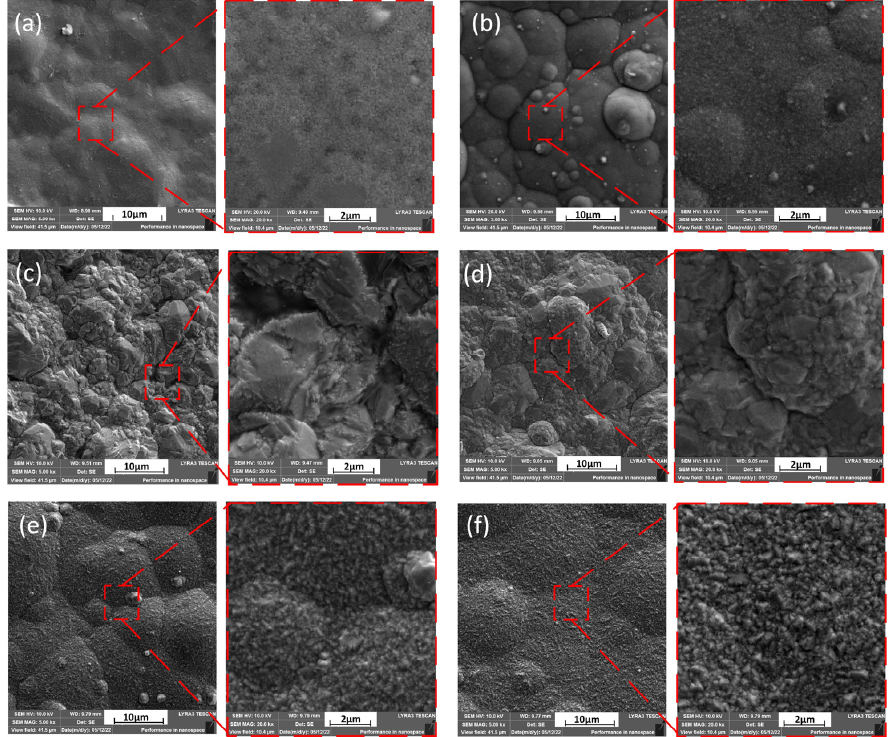
Figure 4. Microstructures of the sample surface and local enlargements of their feature areas at different low temperatures ranging from − 5 ◦ C to 5 ◦ C. ( a ) − 5 ◦ C, ( b ) − 3 ◦ C, ( c ) − 1 ◦ C, ( d ) 1 ◦ C, ( e ) 3 ◦ C, ( f ) 5 ◦ C. ( e , f ) show the electrodeposited copper sample with the smallest grain size and the most delicate structure, followed by ( a , b ). The electrodeposited copper layer in ( c , d ) has the roughest surface and the largest grain size.